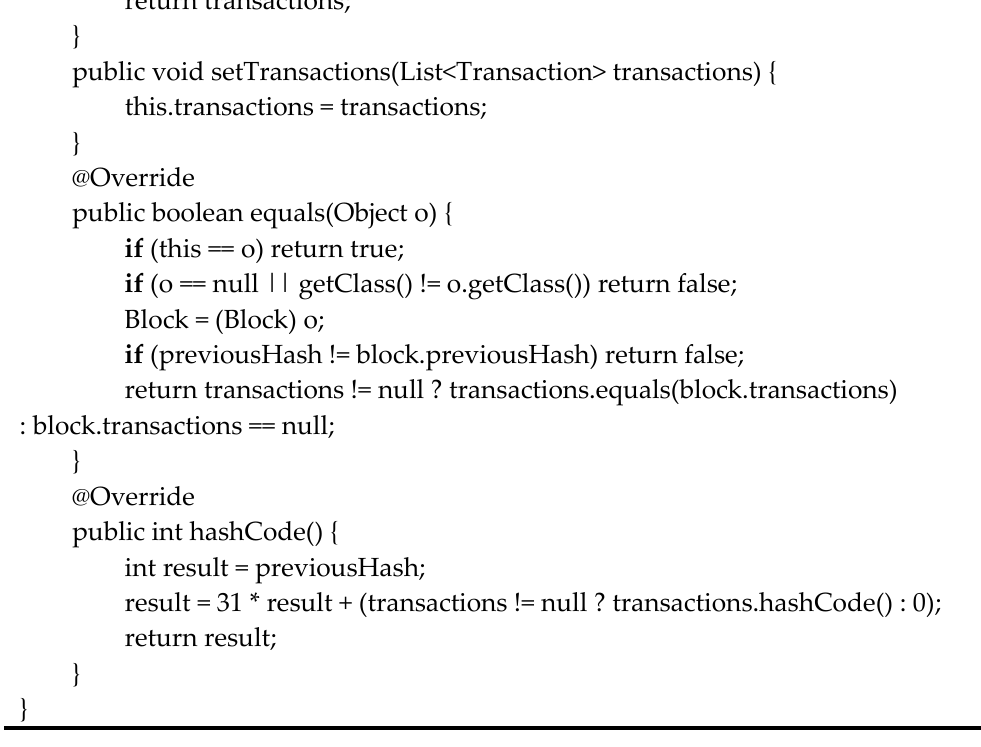
Figure 9. Smart contract calculation source code for real estate.